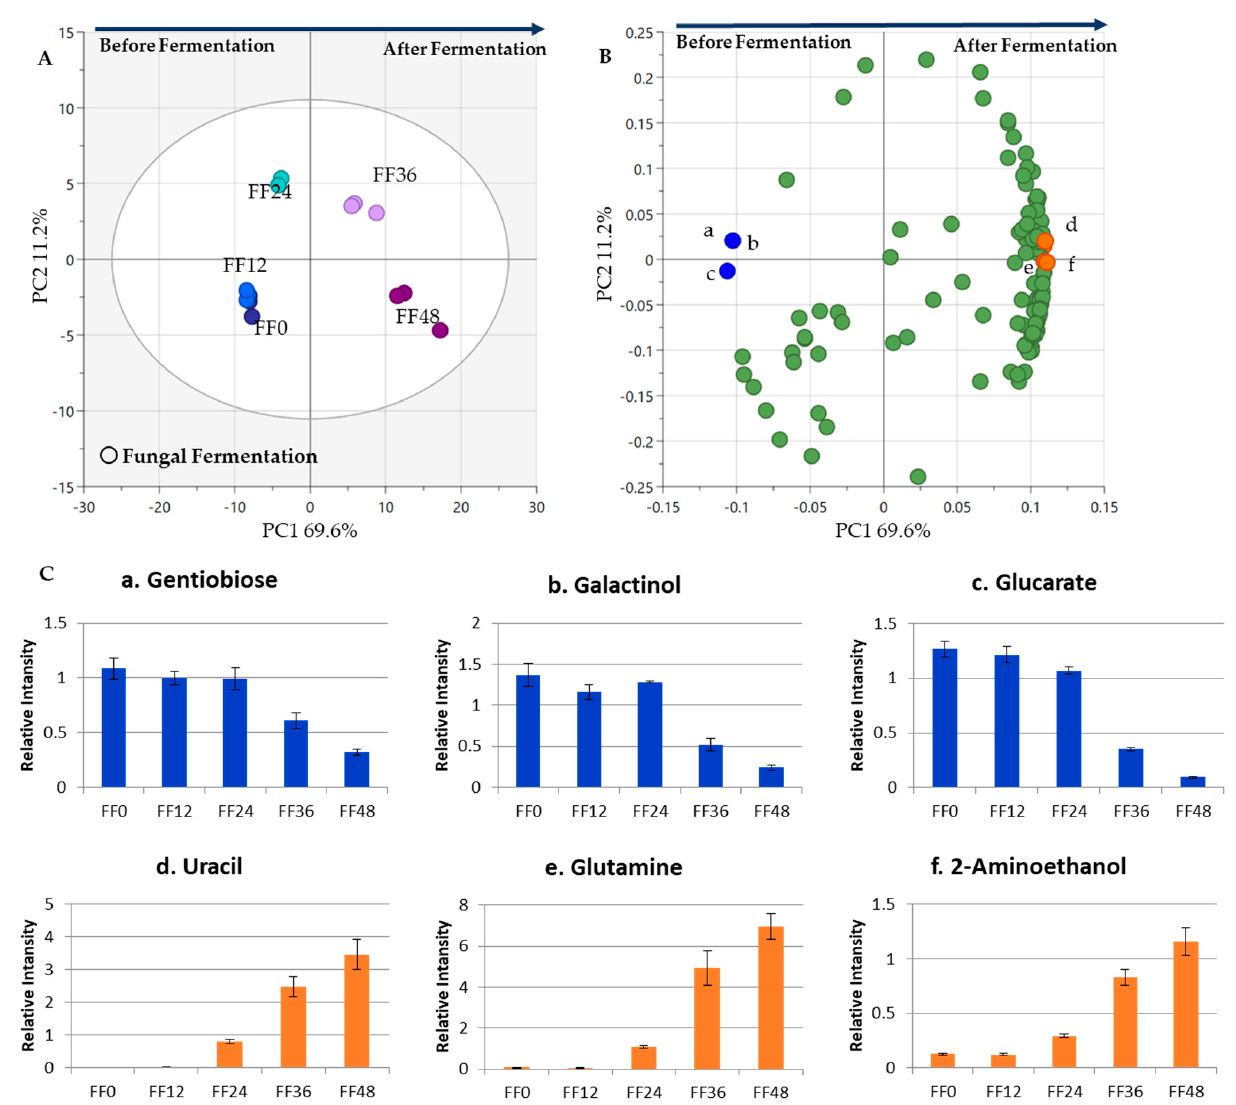
Figure 3. Metabolite changes during the FF process. The PCA results of five soybean samples from different sampling times were obtained to observe the metabolite profile of the fungal fermentation (FF) process. ( A ) The score plot shows the separation between each sample based on sampling time. Samples FF0, FF12, and FF24 were clustered on the negative side of PC1, while FF36 and FF48 clustered on the positive side. The points indicate the treatment times, and the numbers indicate different sampling times in hours (0 h, 12 h, 24 h, 36 h, and 48 h). ( B ) Loading plot. The metabolites as markers from the FF treatment were labeled as follows: (a) gentiobiose; (b) galactinol; (c) glucarate; (d) uracil; (e) glutamine; (f) 2-aminoethanol. ( C ) Bar charts. The metabolites shown in the bar chart are markers from FF. The vertical axis represents relative intensity. The horizontal axis represents the samples. The error bar shows the standard deviation obtained from three replicates.